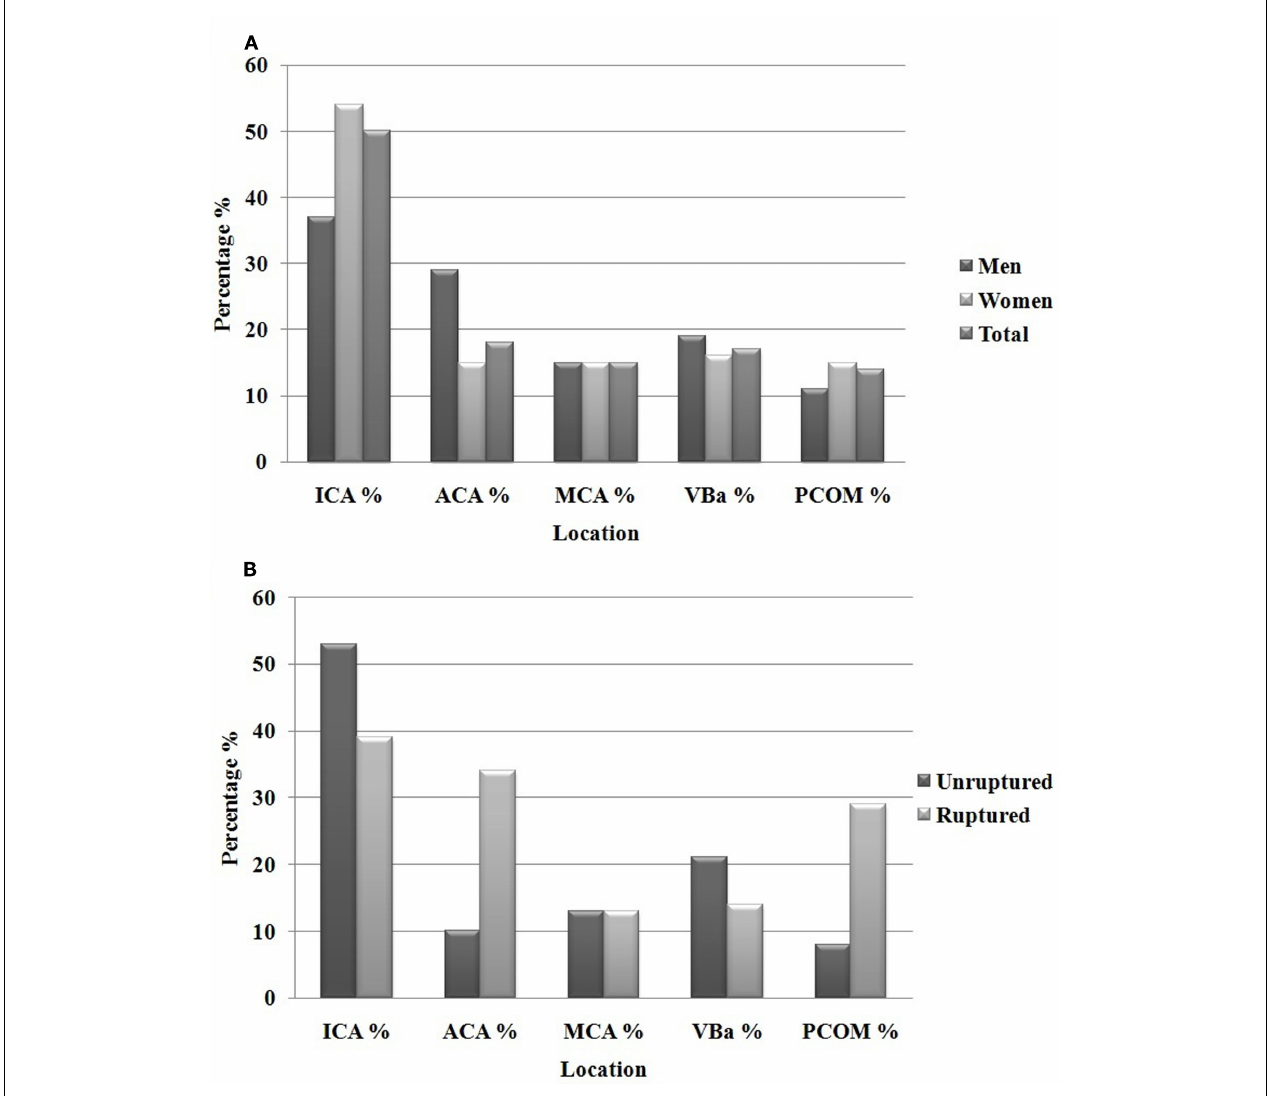
FIGURE 1 |Total aneurysms men and women (682) (A) and location of unruptured compared to ruptured aneurysms (B).